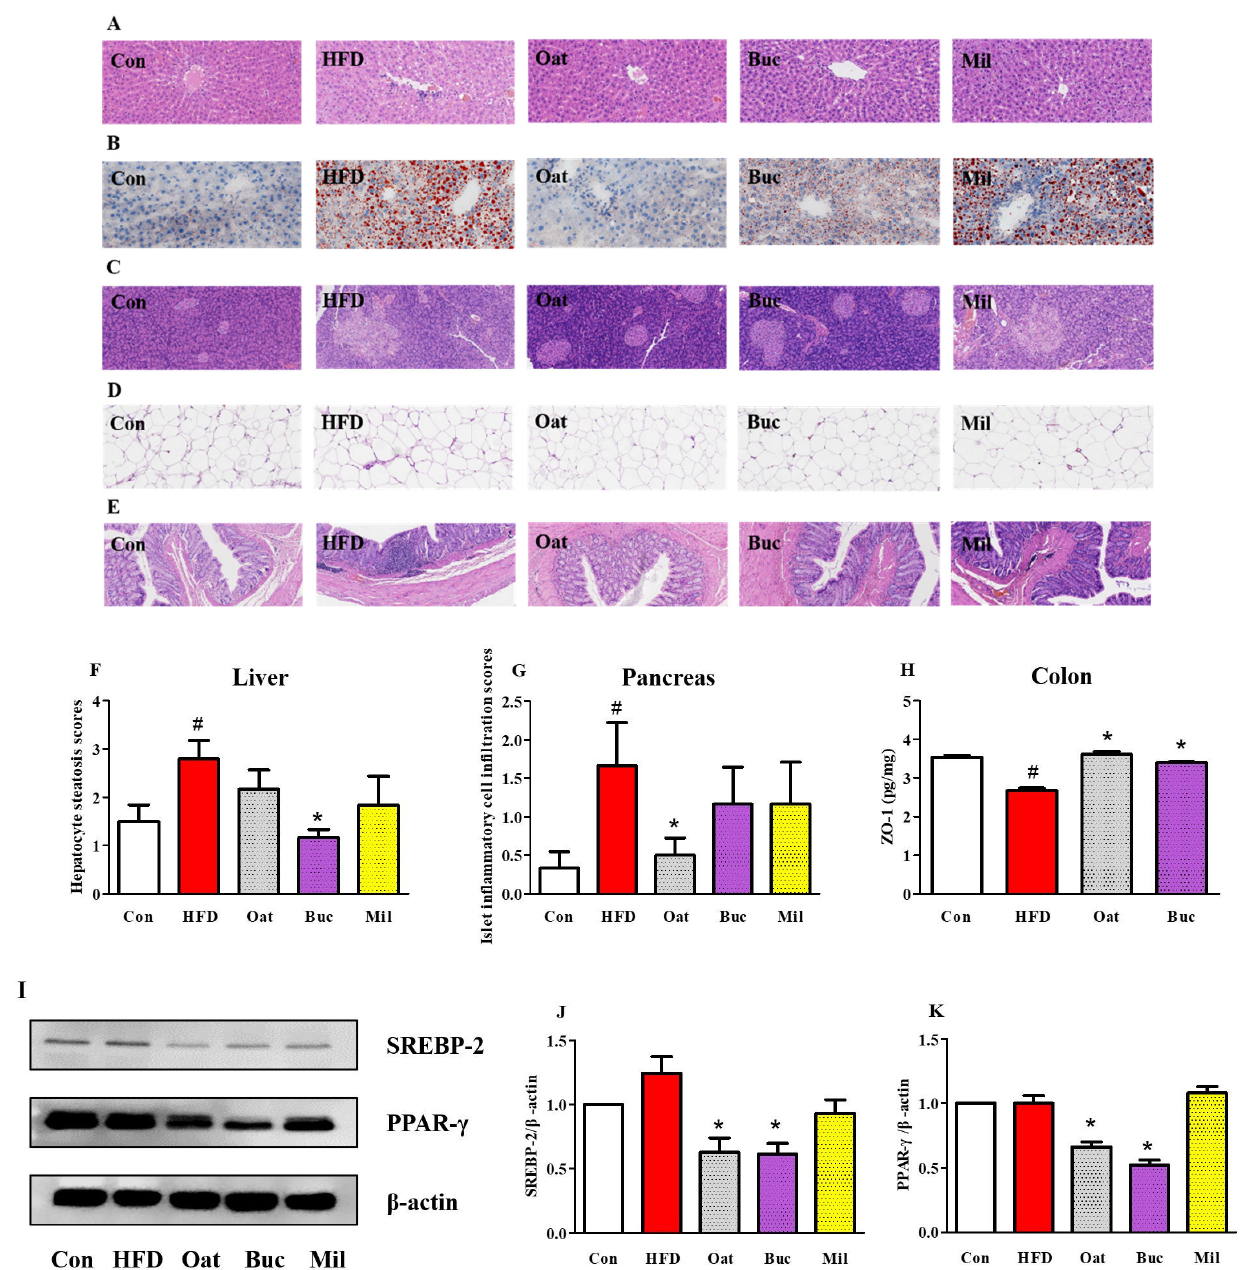
Figure 5. Effect of oats, tartary buckwheat, and foxtail millet supplementation on liver ( A , B ), pancreas ( C ), epididymal adipose ( D ), and colon ( E ) tissues in high-fat diet fed rats. Representative samples of liver tissue were stained with H&E ( A ) and oil red O ( B ). ( F ) Scores based on hepatocyte steatosis in the liver. ( G ) Scores based on inflammatory cell infiltration in the pancreas. ( H ) The protein expression levels of ZO-1 in the colon. ( I ) Western blot bands of SREBP-2 and PPAR- γ in the liver. ( J , K ) Densitometric analysis of SREBP-2 ( J ) and PPAR- γ ( K ) expressions relative to the loading control. Con group, a basal diet group; HFD group, a high-fat diet group; Oat group, HFD containing 22% oat group; Buc group, HFD containing 22% tartary buckwheat group; Mil group, HFD containing 22% foxtail millet group; ZO-1, zonula occludens-1; SREBP-2, sterol regulatory element-binding protein 2; PPAR- γ , peroxisome proliferator-activated receptors γ . Data are presented as the mean ± SD ( n = 6). # p < 0.05, compared to Con group, * p < 0.05, compared to HFD group.